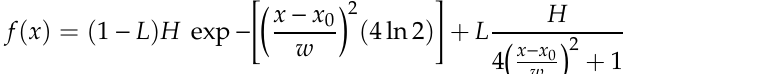
Figure 4. FTIR spectra of neat and nanocomposite systems cured up to 125°C for 1 h.